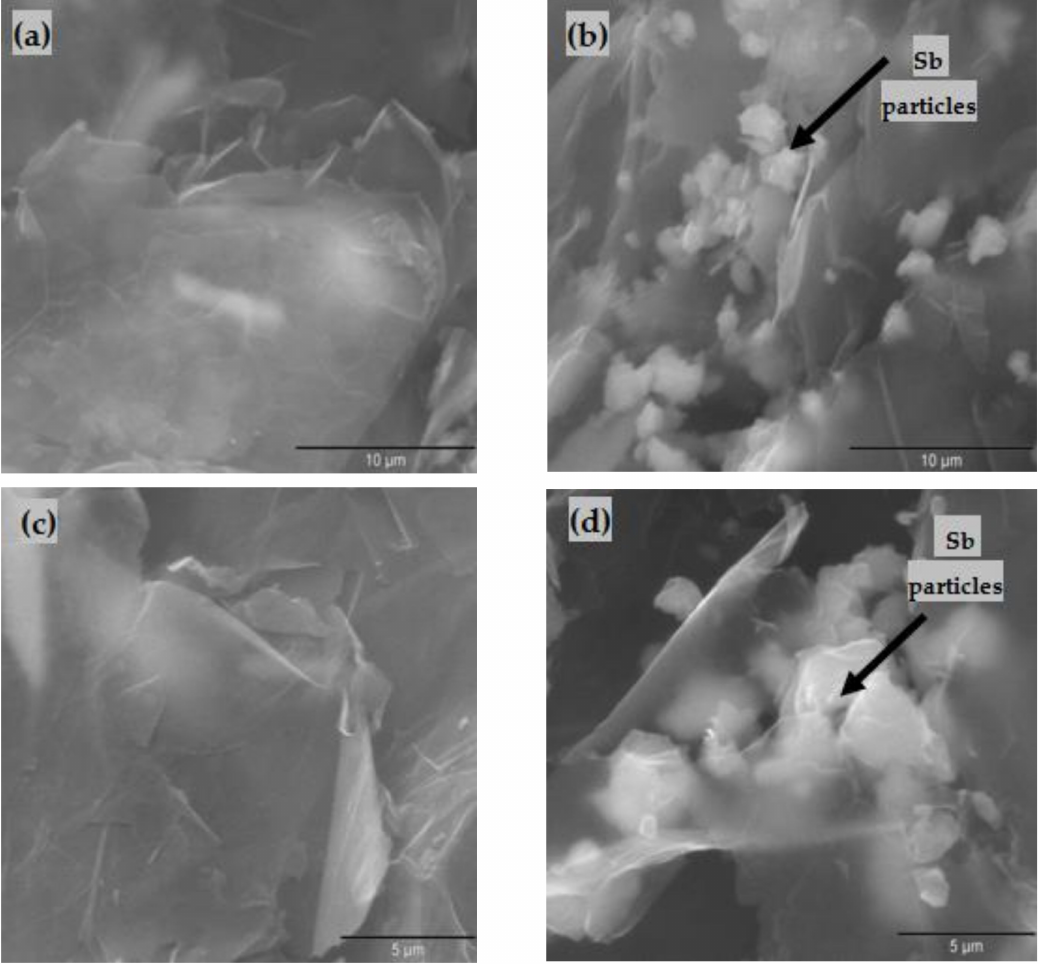
Figure 3. SEM images ( a , c ) ox-xGnP before adsorption of Sb at magnifications of 10,000 × and 15,000 × , respectively; ( b , d ) ox-xGnP after adsorption of Sb at magnifications of 10,000 × and 15,000 × ,